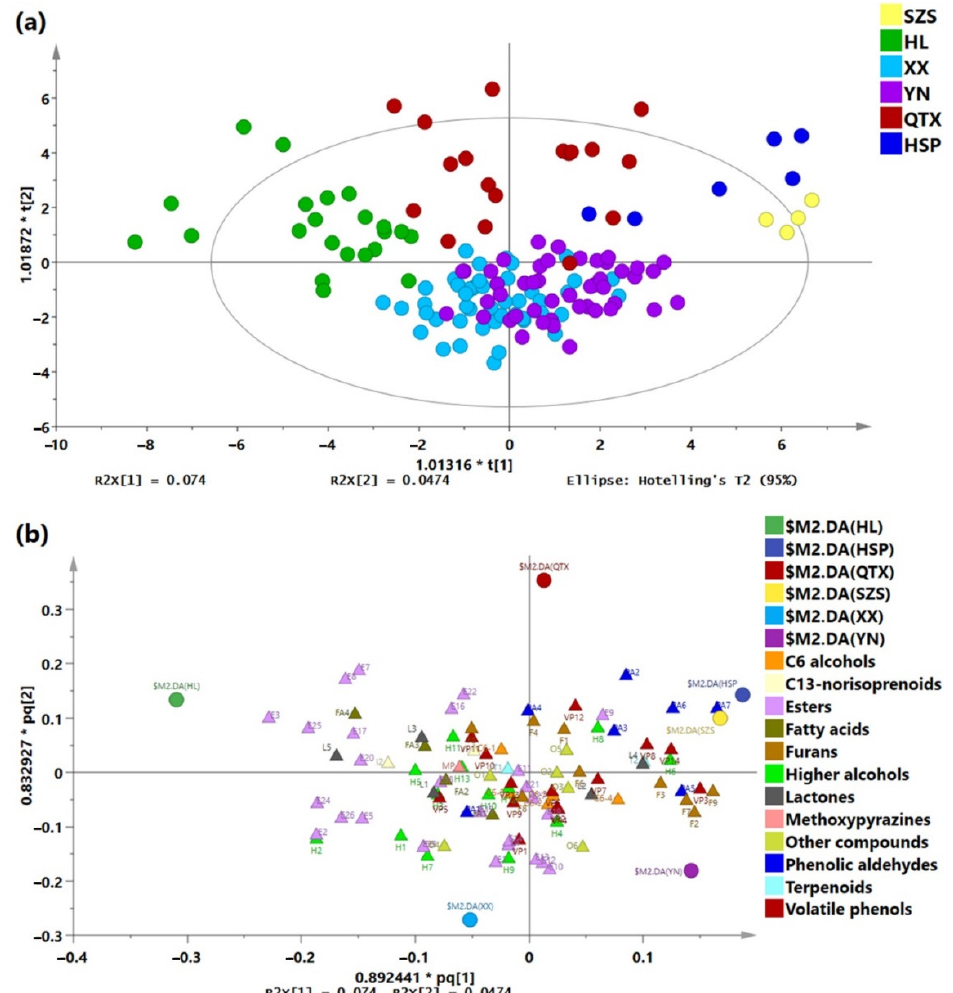
Figure 2. O2PLS-DA model based on the quantitative data of volatile compounds of Cabernet Sauvignon dry red wines from six sub-regions of the Eastern Foothills of Helan Mountain in Ningxia. ( a ) Score scatter plot for Cabernet Sauvignon dry red wines samples based on the replicate of each sample. ( b ) Loading plot for the volatile profiles of Cabernet Sauvignon dry red wines. The labels of volatile compounds are in accordance with Table S3. SZS, Shizuishan region; HL, Helan region; XX, Xixia region; YN, Yongning region; QTX, Qingtongxia region; HSP, Hongsipu region.